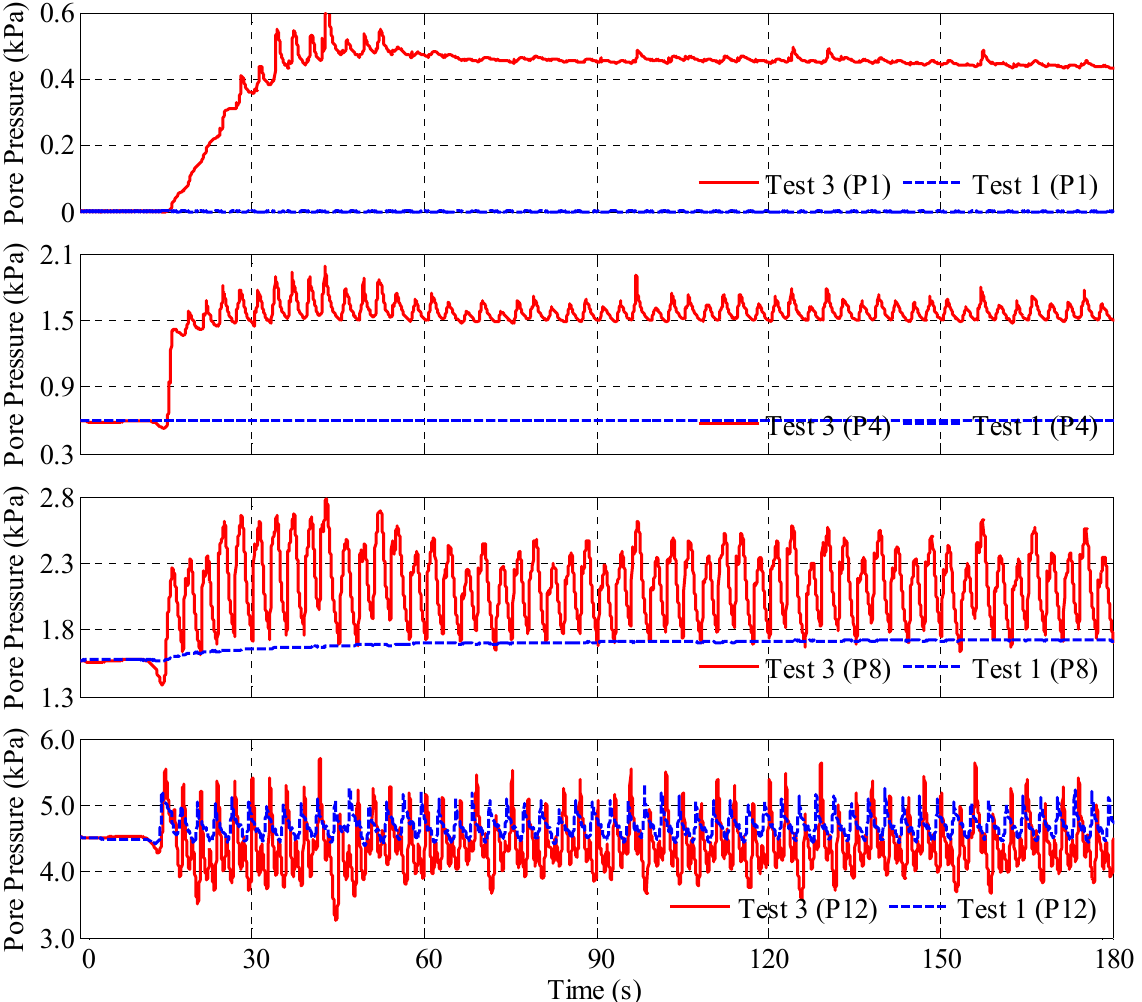
Figure 16. Comparison of pore pressure recorded at P1, P4, P8 and P12 between Test 3 ( d = 0.71 m) and Test 1 ( d = 0.48 m).